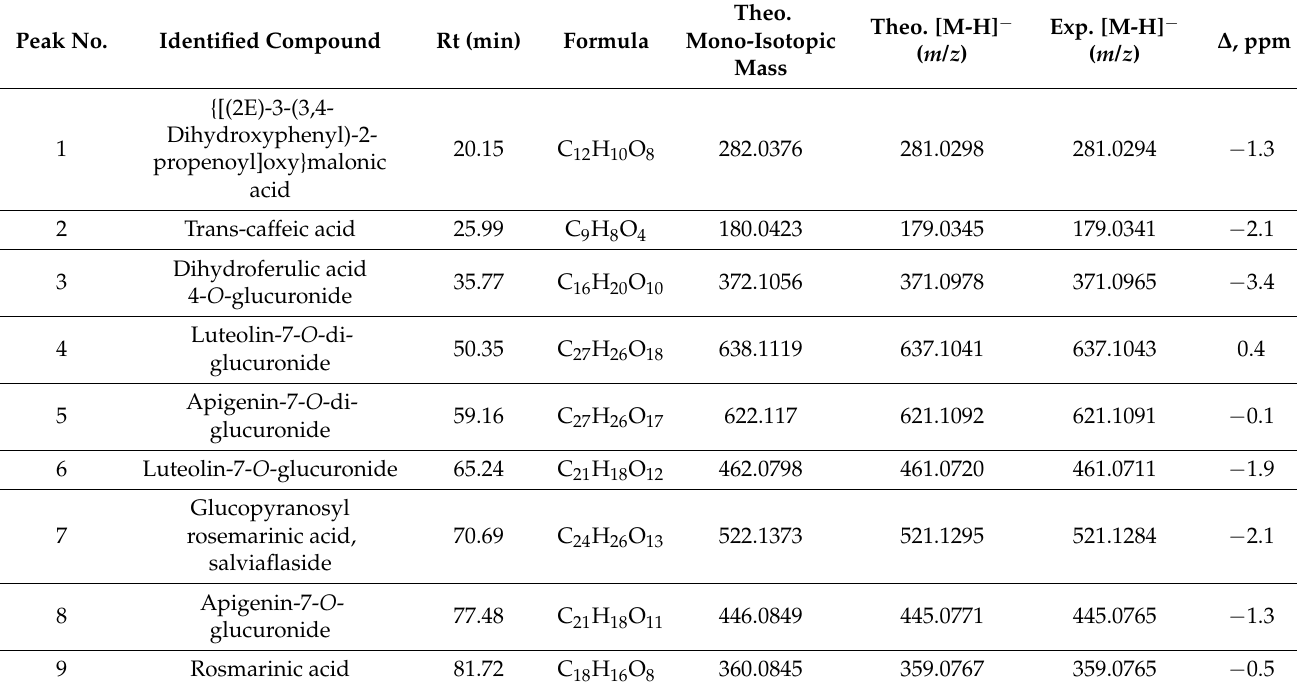
Table 1. Marker compounds selected from the analyses of the GHL extracts.